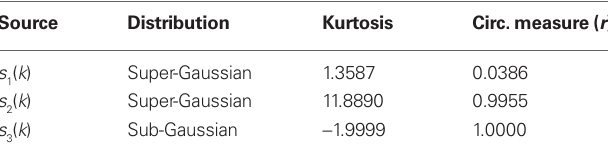
Table 1 | Source properties for noise-free extraction benchmark simulation 1.